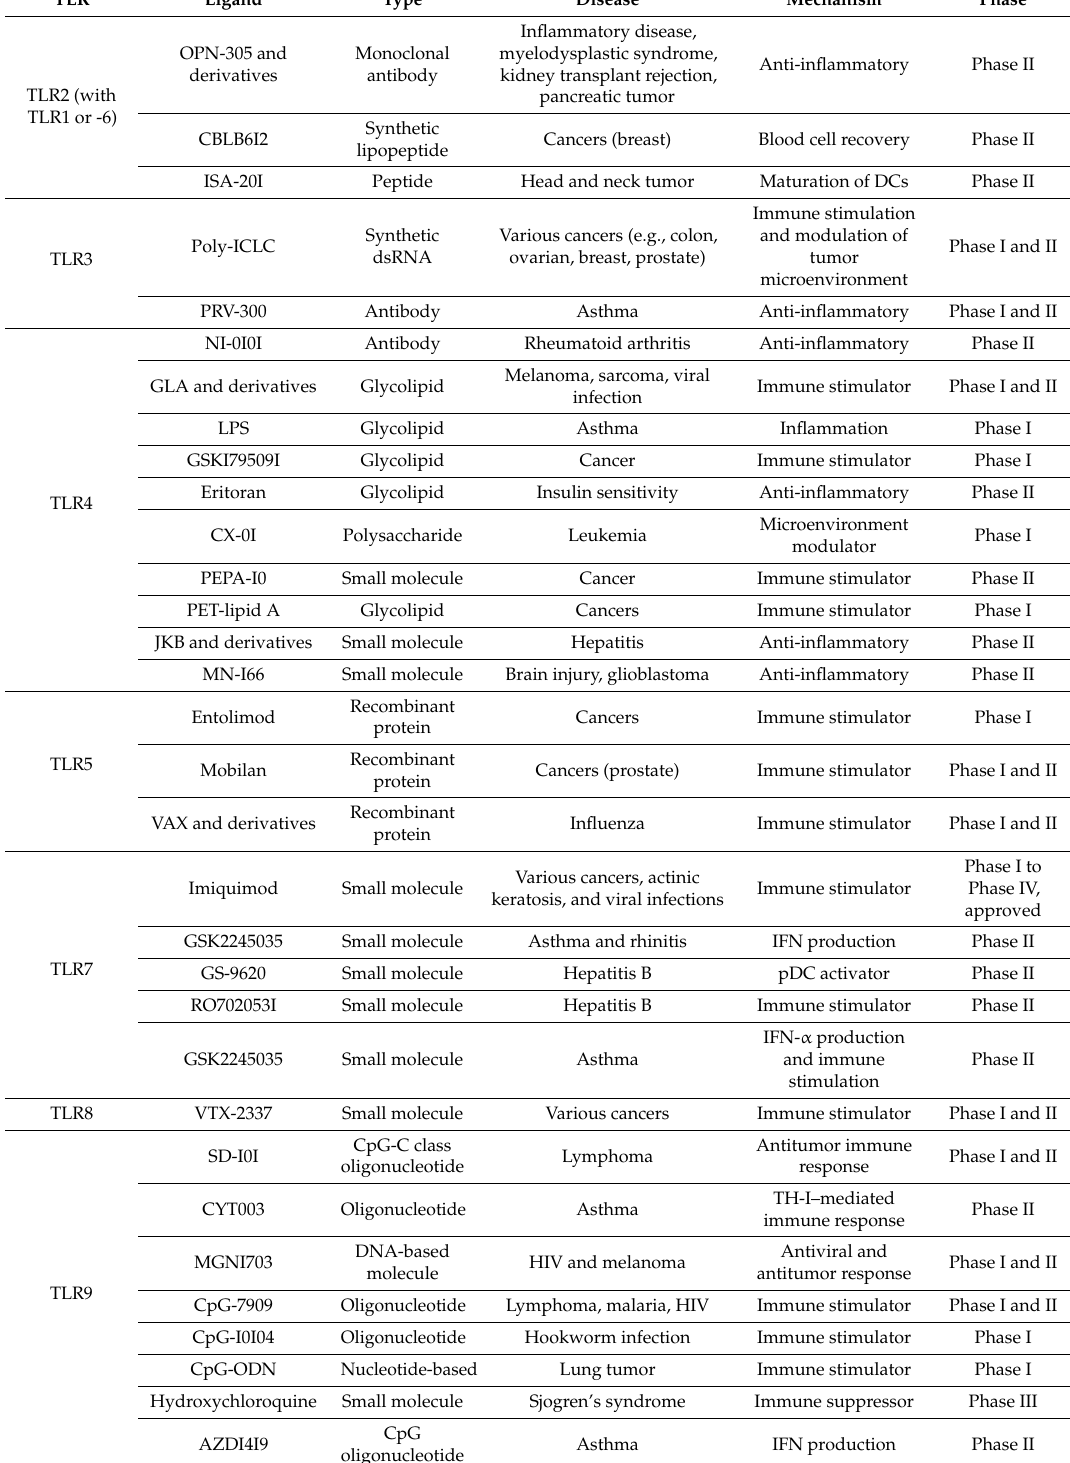
Table 2. TLR-targeting drugs in clinical